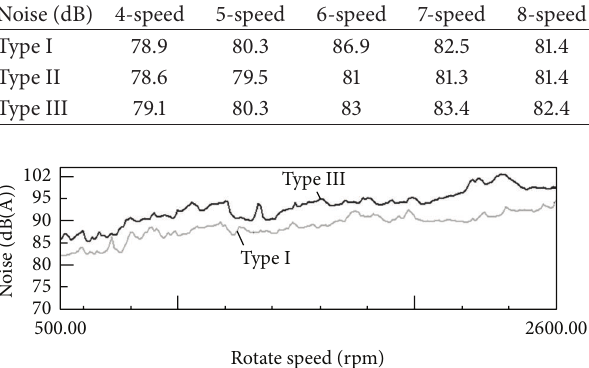
Figure 2: The transmission noise with the changing of the input speed.